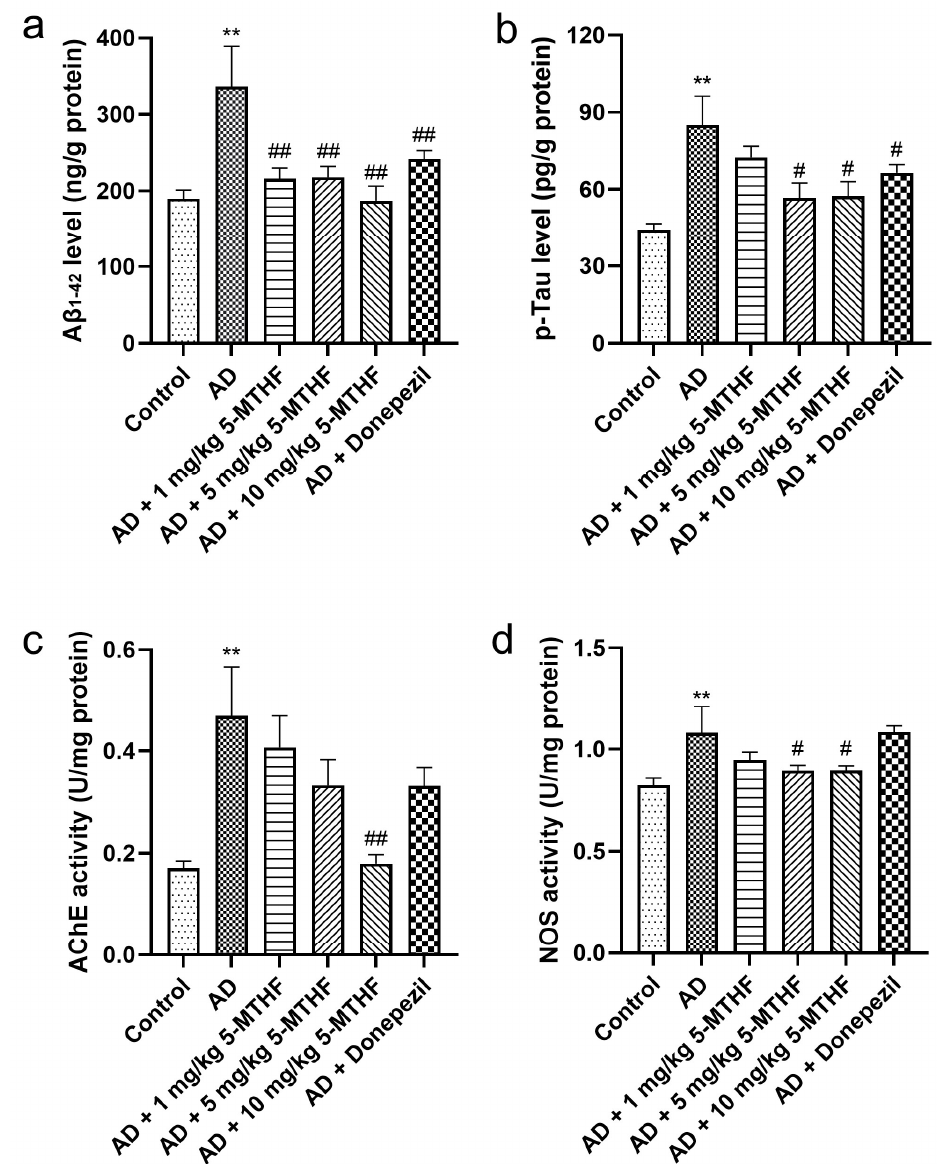
Figure 3. Aβ 1-42 and p-Tau contents and AChE and NOS activities in brain tissue. ( a ) Aβ 1-42 , ( b ) p-Tau, ( c ) AChE and ( d ) NOS. Data are shown as mean ± SEM. ** p < 0.01 compared with controls. # p < 0.05, ## p < 0.01 compared with the model group.